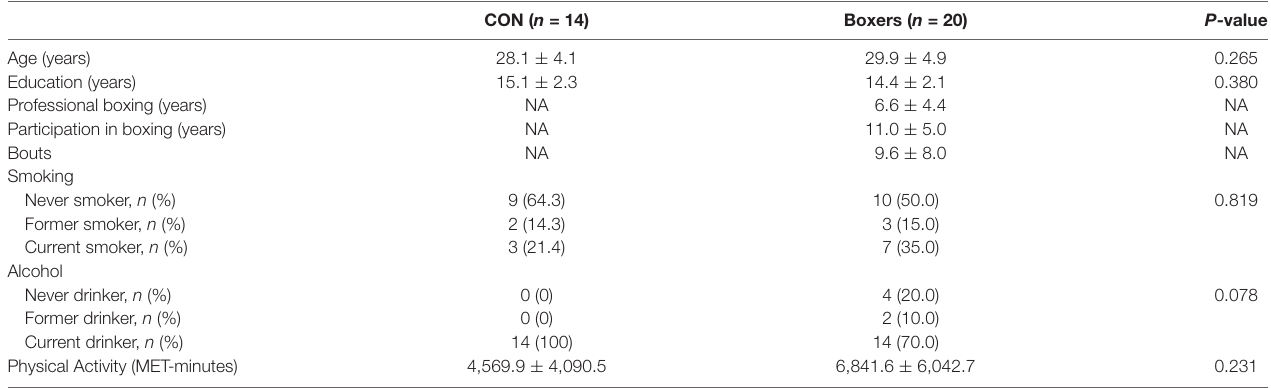
TABLE 1 | Demographic and clinical characteristics of study participants.